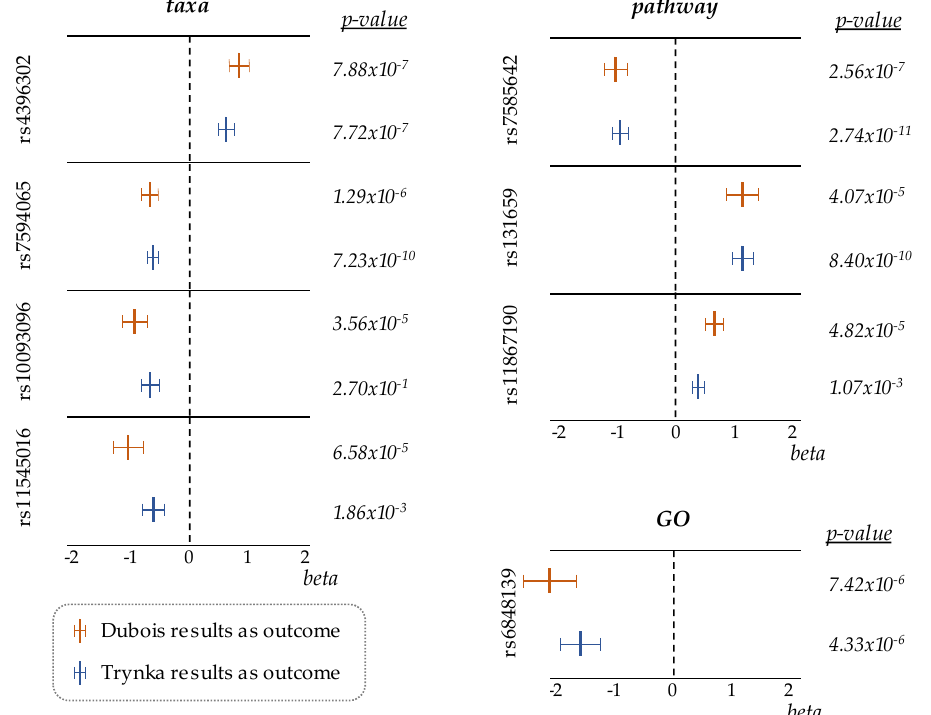
Figure 2. Forest plots, comparing effect-sizes and p -values of SNPs identified in taxa, pathway, and GO categories, in two independent 2SMR analyses where either Dubois or Trynka CeD datasets were used as outcome data.